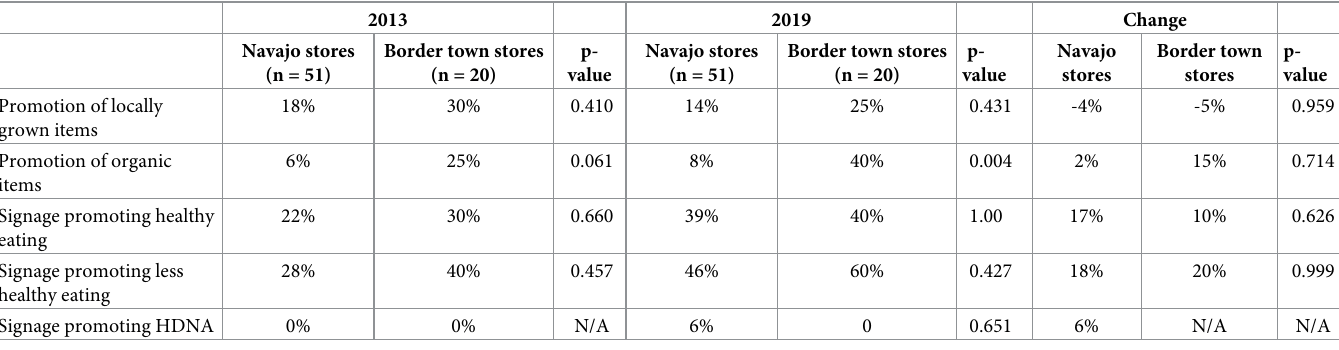
Table 4. Changes in promotion and signage among Navajo and border town stores, n =